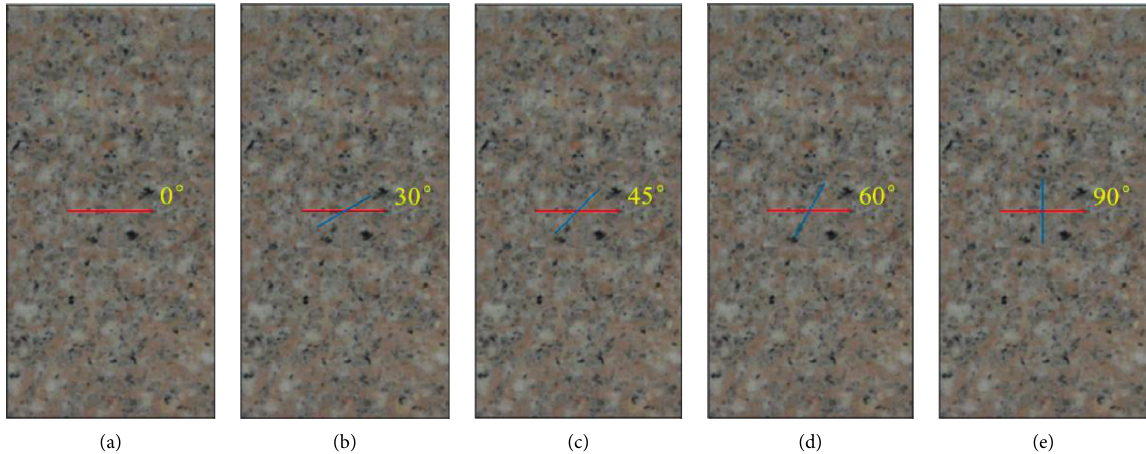
Figure 1: Preexisting conjugate joints with different included angles. (a) α � 0 ° , (b) α � 30 ° , (c) α � 45 ° , (d) α � 60 ° , and (e) α � 90 °